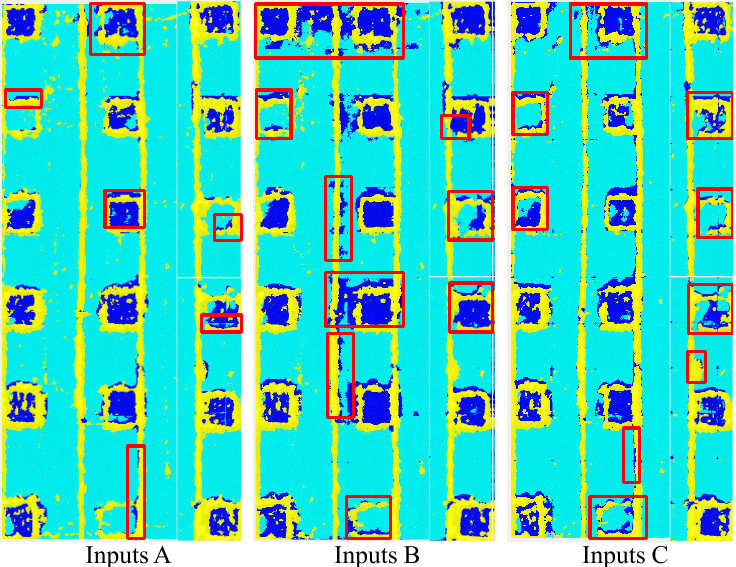
Figure 13. Segmentation maps of different inputs using Ir-UNet.